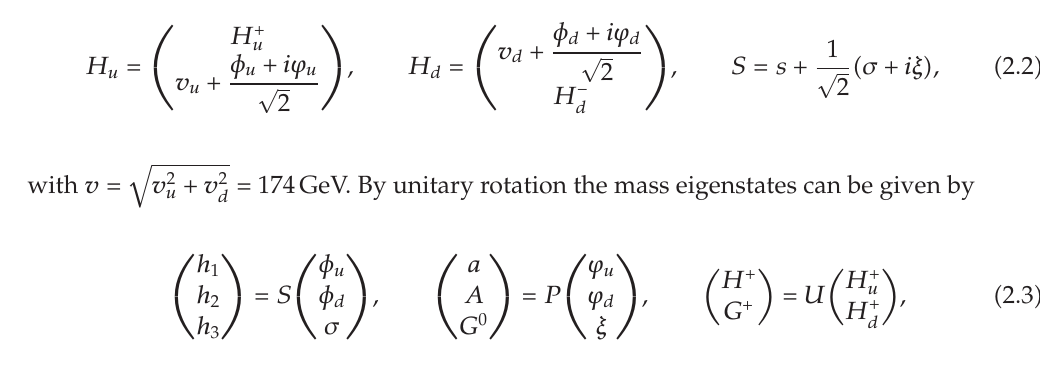
Figure 1: The scatter plots of the samples in the MSSM and NMSSM (cid:3) with λ > 0.53 (cid:4) satisfying various constraints listed in the text (cid:3) including 123GeV ≤ m h ≤ 127GeV (cid:4) , showing the correlation between the mass of the lighter top squark and X t /M S with M S ≡ the circles (cid:3) green (cid:4) denote the pull-down case (cid:3) the lightest Higgs boson being the SM-like Higgs (cid:4) , and the times (cid:3) red (cid:4) denote the push-up case (cid:3) the next-to-lightest Higgs boson being the SM-like Higgs (cid:4) .